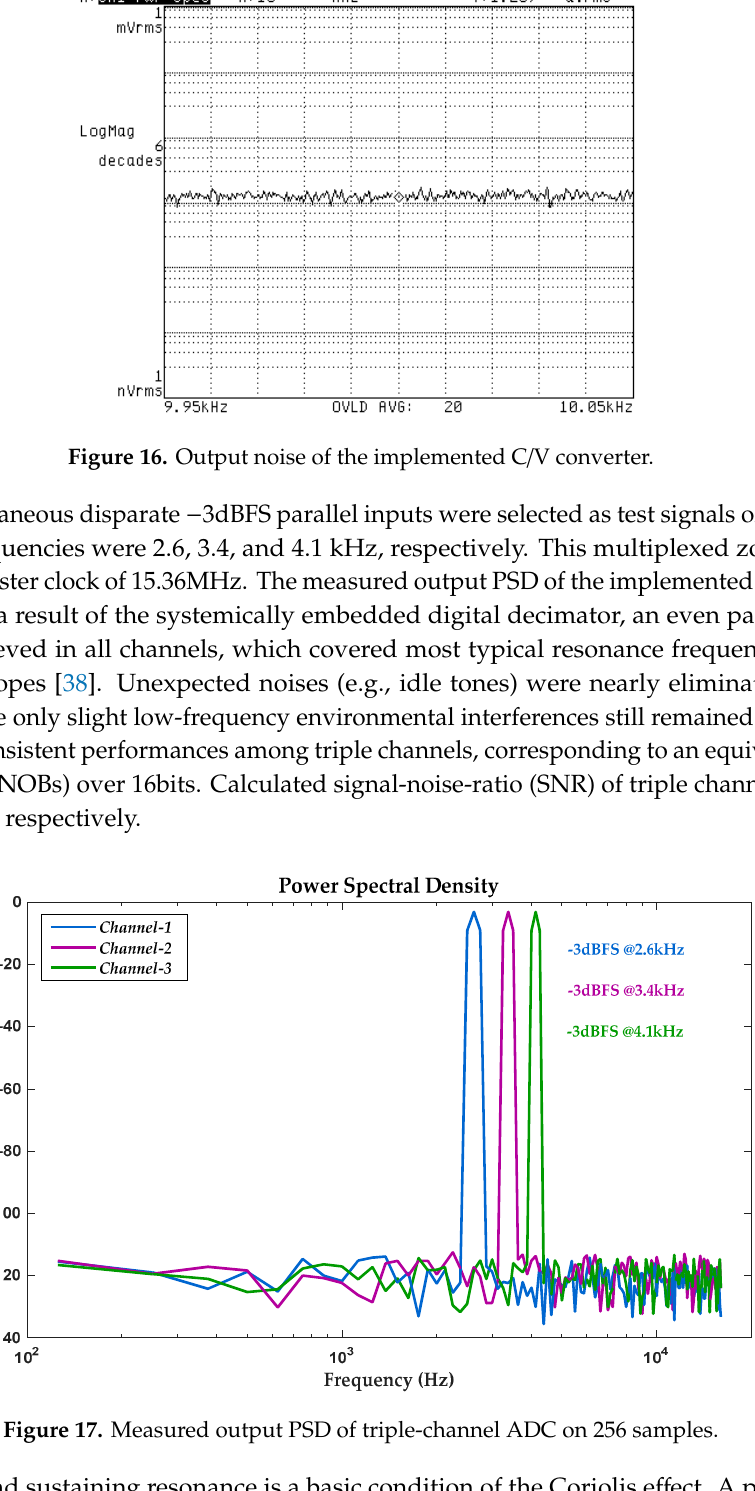
Figure 18. Start-up process of the closed drive loop.